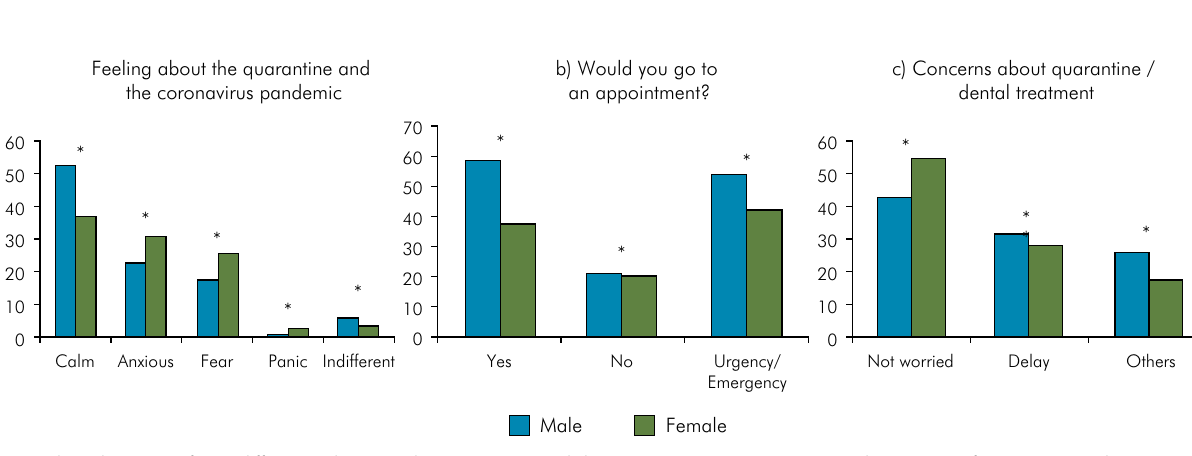
Figure 2. Comparison of patients under dental treatment or not.